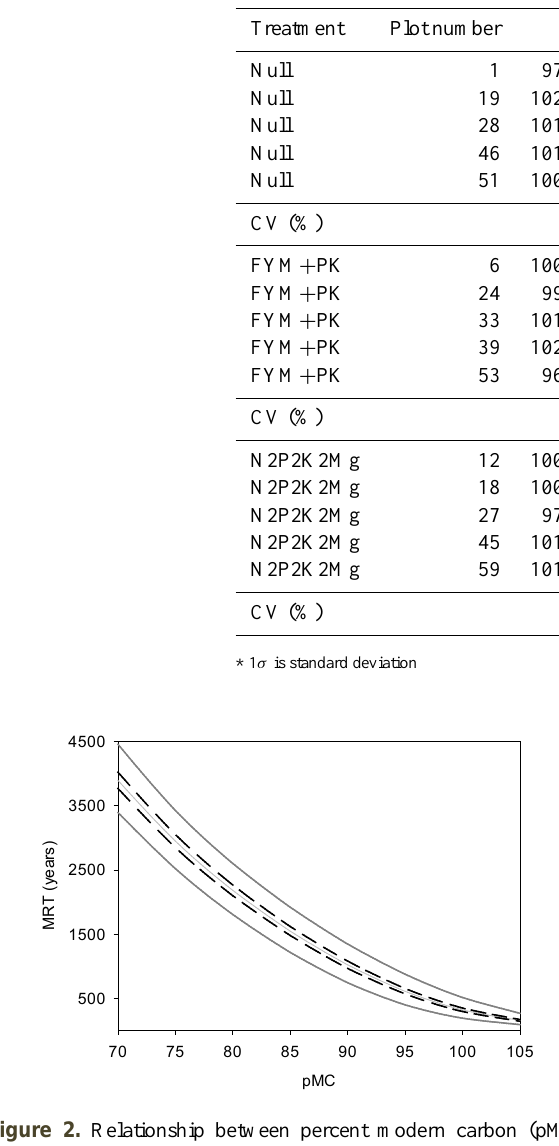
Figure 2. Relationship between percent modern carbon (pMC) and calculated carbon mean residence time (MRT) using a time- dependent steady-state single-pool turnover model. The inner line refers to mean values, the dashed band to the 95% uncertainty range related to the average 14 C analytical error, and the outer, solid band to the 95% uncertainty range related to the average experimental 14 C variability in the